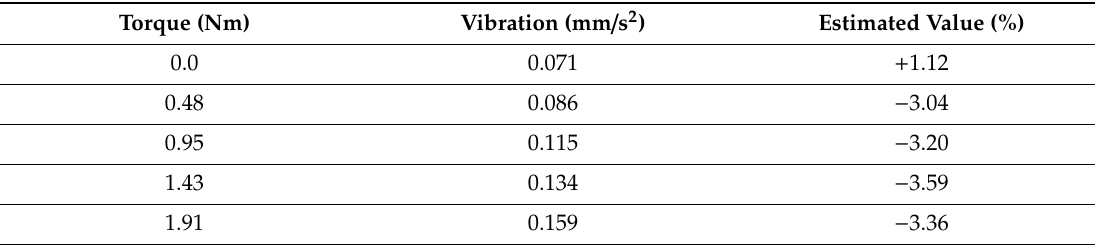
Table 5. Estimation of the demagnetization level of an axially demagnetized PM using the 12th vibration